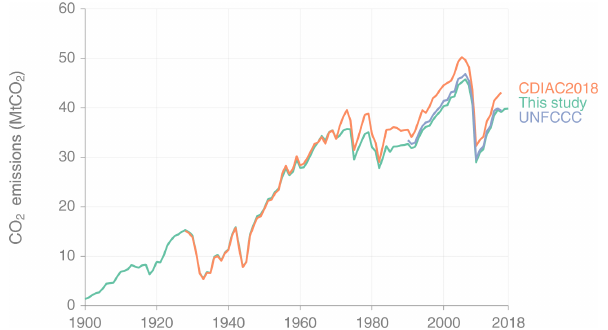
Figure C8. Revised cement emissions for